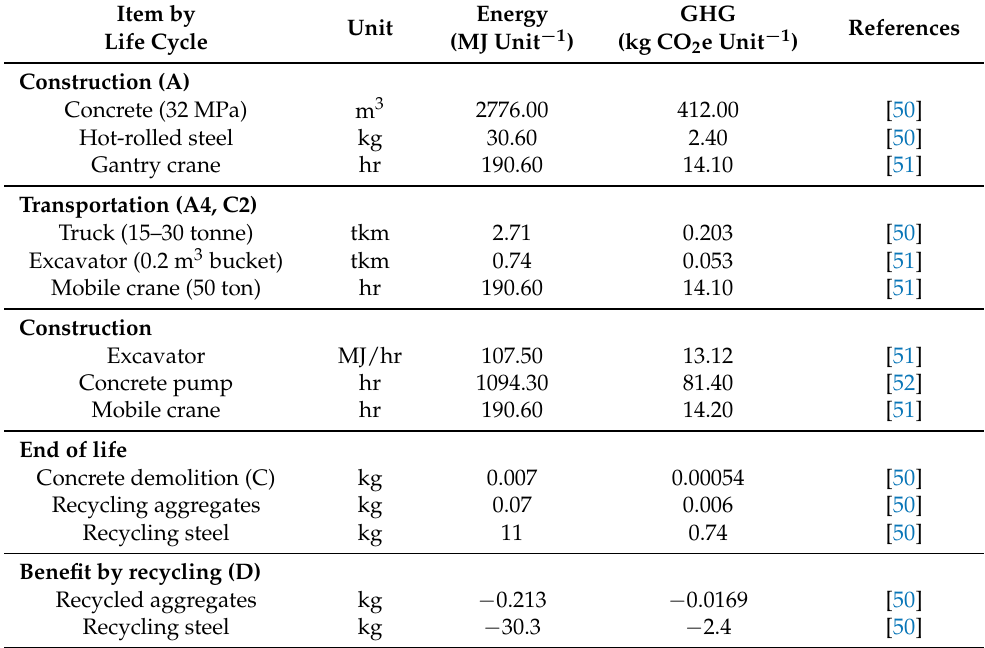
Table 6. Energy and GHG emission factors used for life cycle assessment of both footing system. Item